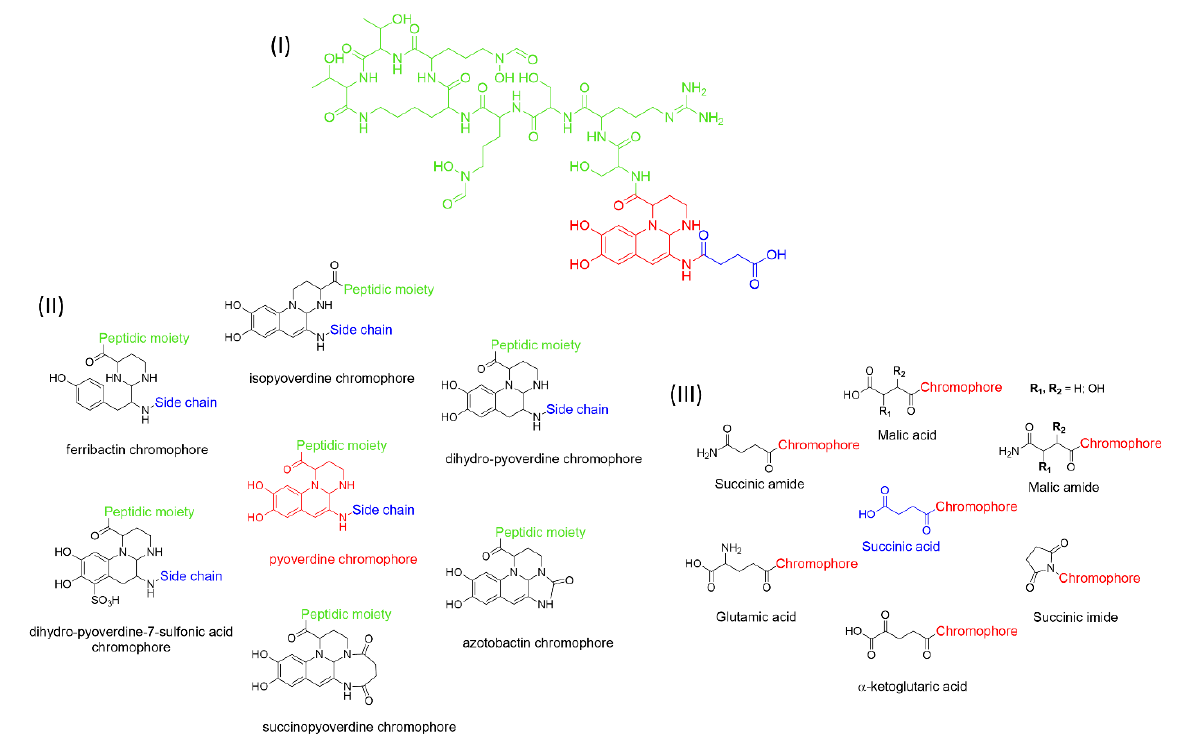
Figure 1. Structure of pyoverdine type 1 produced by P. aeruginosa ( I ); examples of different PVDs’ chromophore structures ( II ); illustration of different side chains characteristic of PVDs ( III ). Table 1. Representative list of siderophores belonging to the class of hydroxamate, catecholate, carboxylate, and mixed ligands.